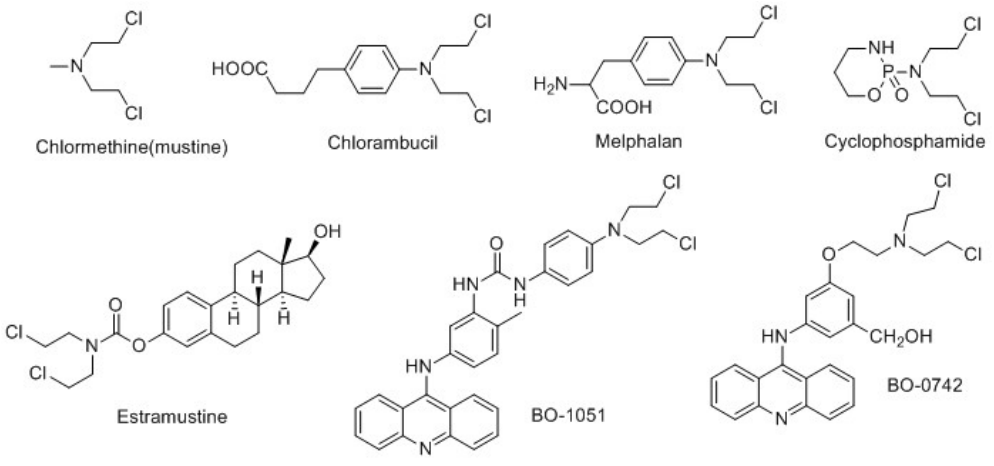
Figure 1. Chemical structures of N -mustard antineoplastic drugs and